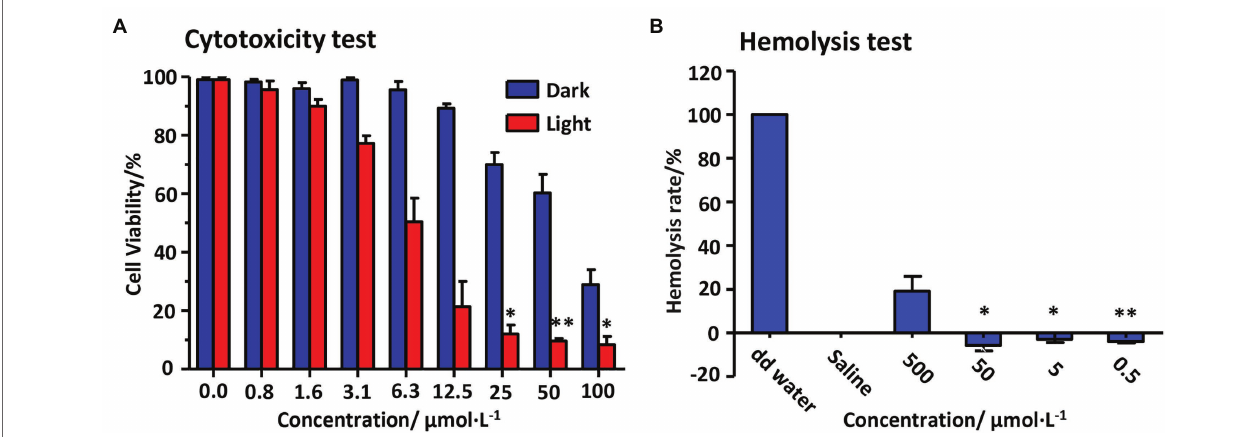
FIGURE 7 | Biosafety of PcG 3 K 5 (RW) 3 in vivo to human embryonic lung fibroblast (HELF) cells (A) with or without light illumination (12 J/cm 2 , 33.33 mW/cm 2 ) and to the red blood cells (B) . Pure water was used as a control. Error bars indicated SD for three replications. * and ** indicated significant differences ( p < 0.05 and p < 0.01, respectively) from the corresponding control